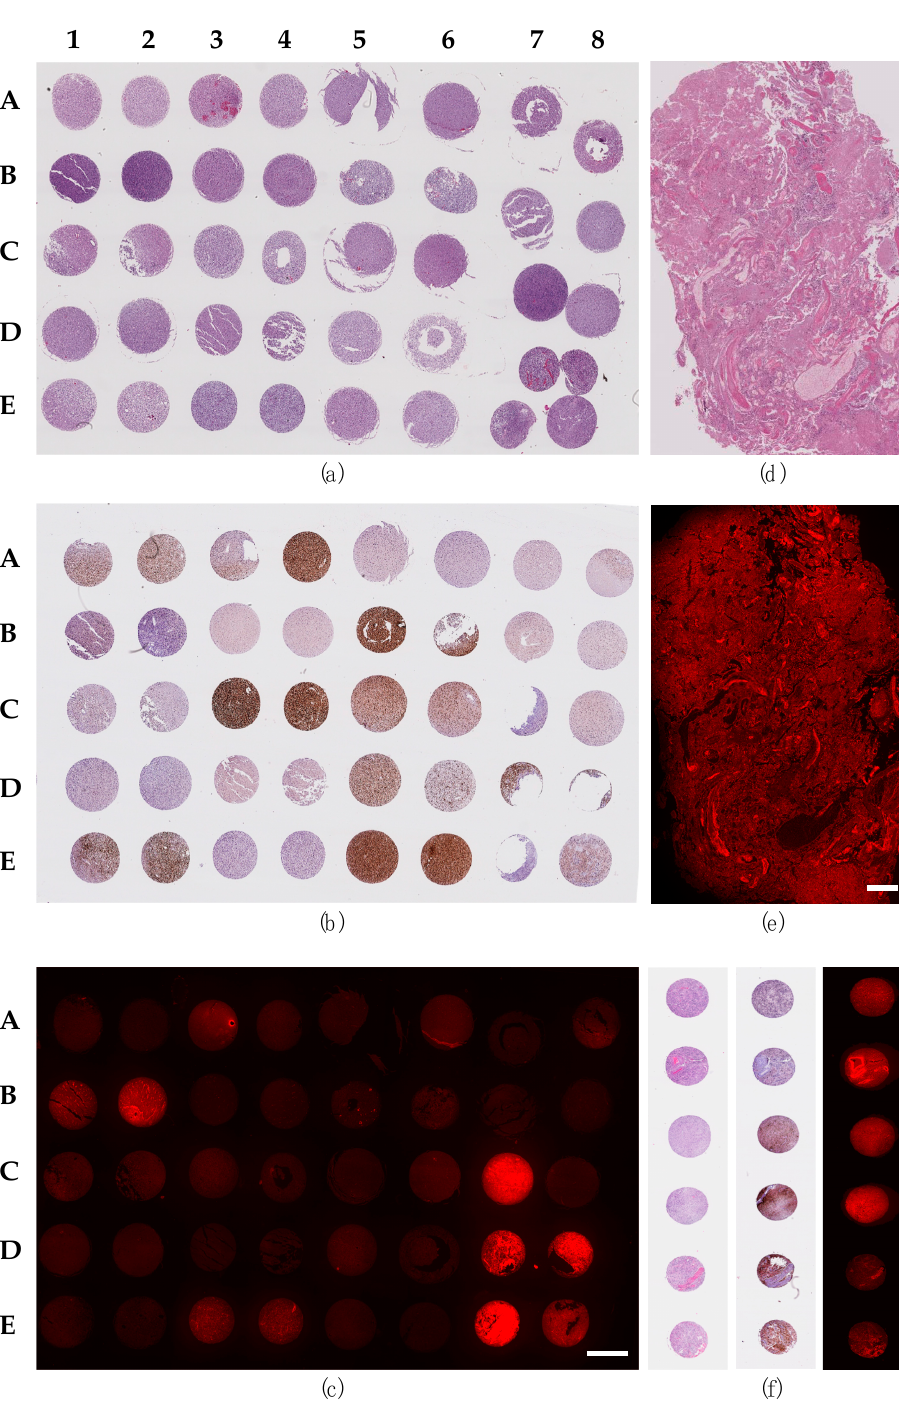
Figure 1. Staining for the PTP µ biomarker and mutant IDH1. These are representative examples of a TMA ( a – c , f ) or an individual slide ( d – e ) stained with the relevant markers. The patient samples are marked in rows A–E with numbers at the top from 1–8. Therefore, the tumor core location is referred to as A1, A2, etc. ( a ) Hematoxylin and eosin (H&E) stain of the TMA. ( b ) Mutant IDH1 staining of the TMA. ( c ) SBK4-TR stain of the TMA. ( d ) H&E of individual sample of GBM. ( e ) SBK4-TR stain of the same individual. Panel ( f ) shows results from a different TMA with H&E (left), mutant IDH1 (middle) and SBK4-TR (right) staining with a range of PTP µ high to PTP µ low and both wild-type and mutant IDH1. Scale bar =